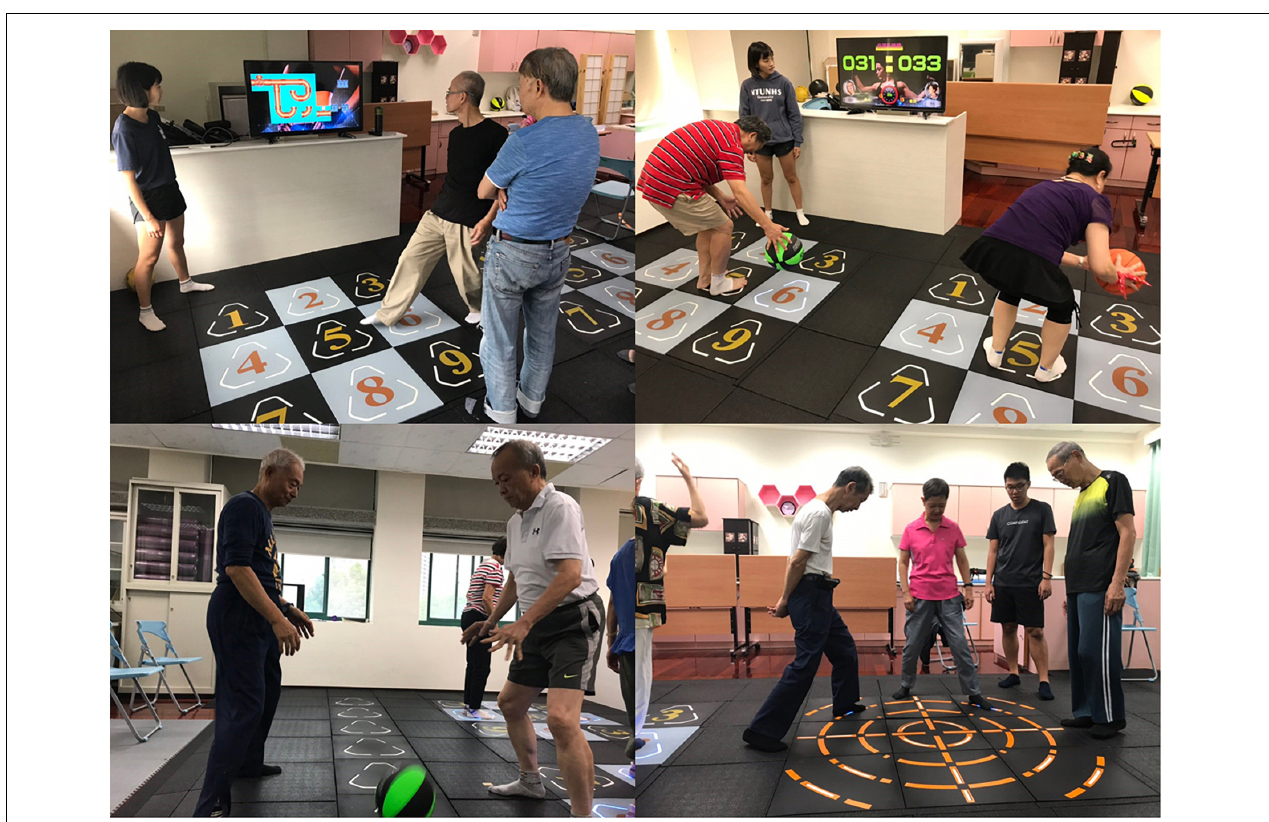
FIGURE 1 | Example of mat exergame with simultaneous cognitive–physical training. (A) Participants performing steps on the three-by-three grid-type mat to play a puzzle game. (B) Participants competing against each other to hit each light on the grid to turn it “off” the most quickly. (C) Participants walking sideways to play a reaction time game with a basketball (turning the light “off” in a random order) on the ladder-type mat. (D) Participants performing verbal memory exercises on the circle-type mat for balance and agility